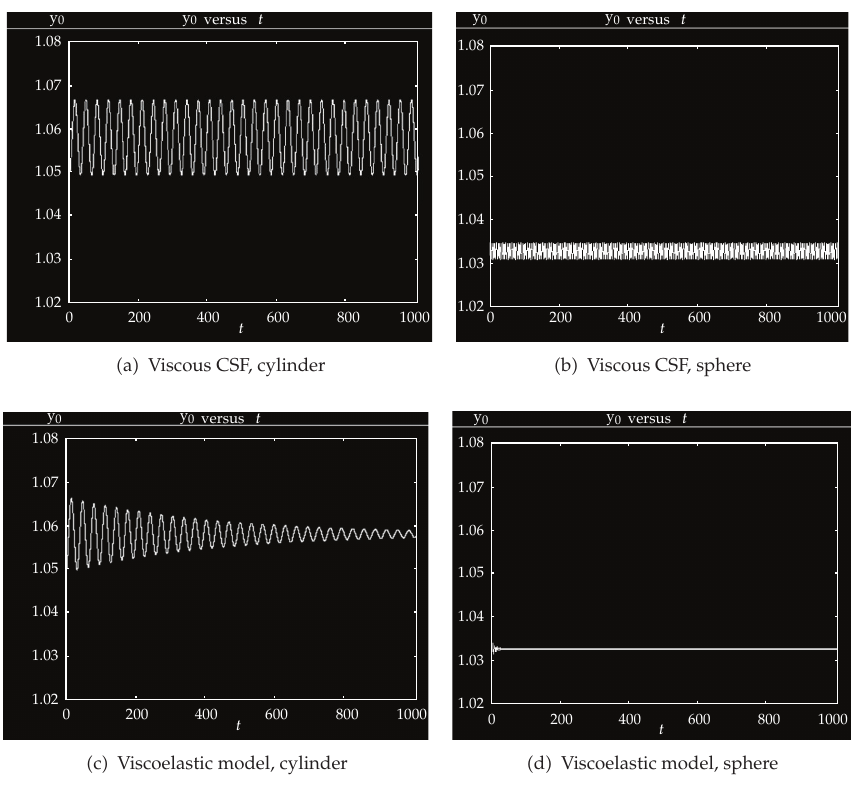
Figure 8: Stretch ratio for cylindrical versus spherical